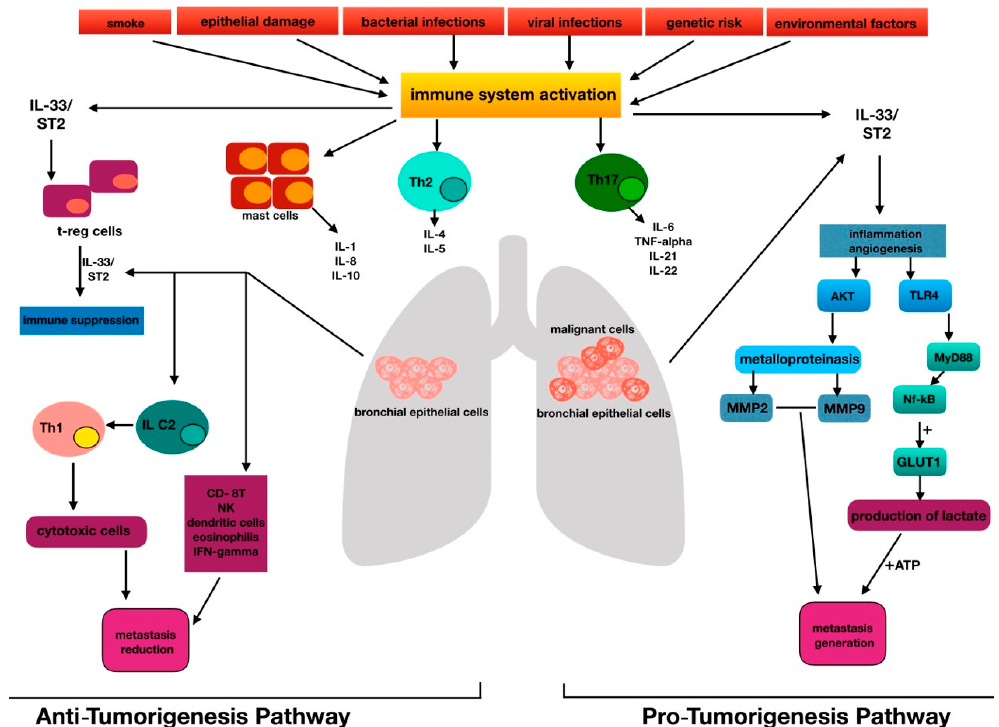
Figure 1. The figure represents the interleukin-33 (IL-33) paradox, highlighting the centrality of IL-33 in the pathogenesis of lung cancer for immune system regulation, metabolic activity, and the metastasis genesis process.